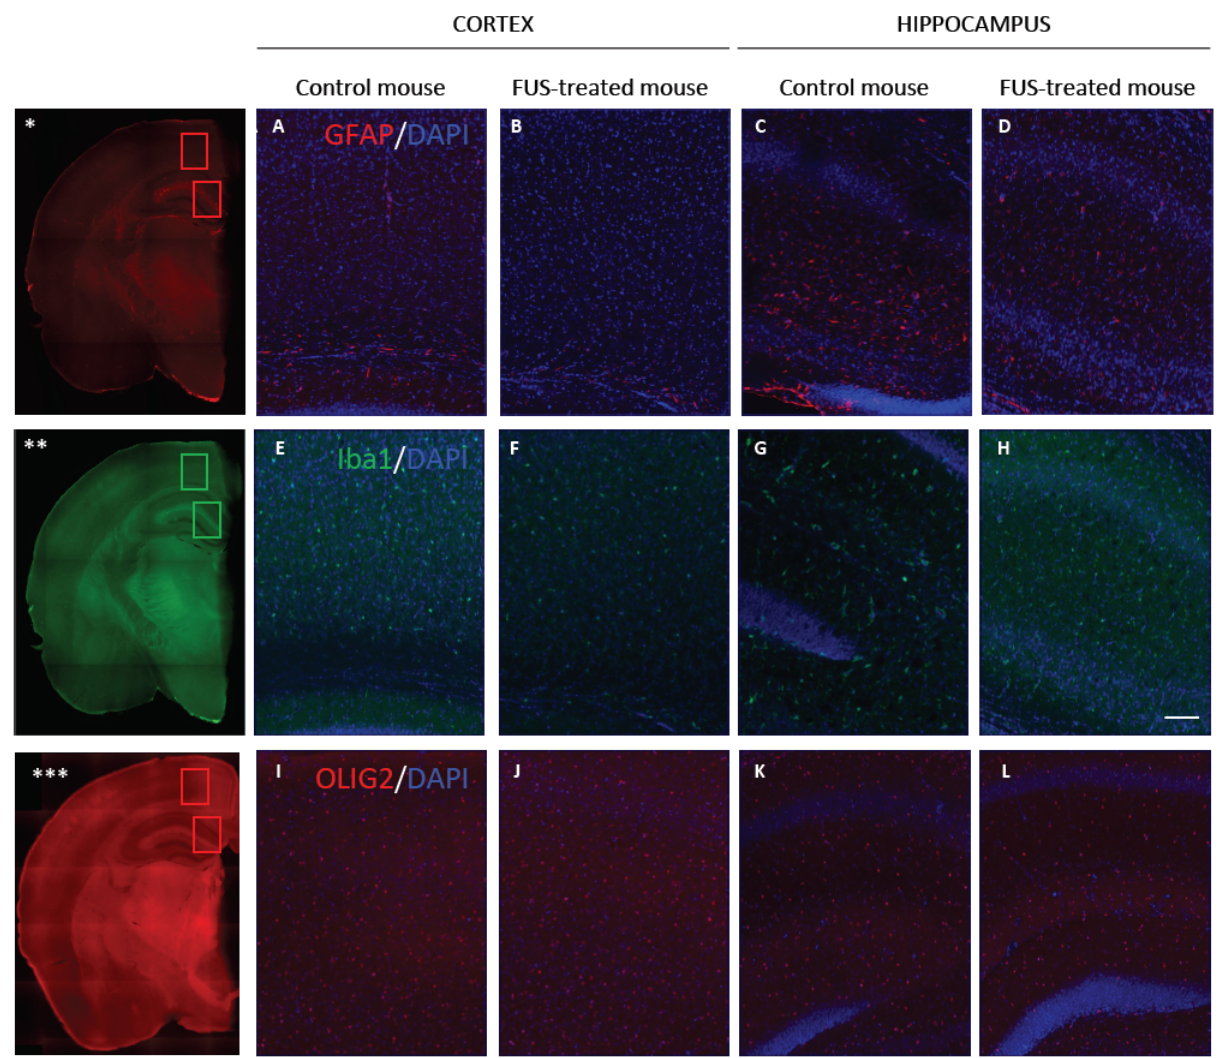
Figure 5. Long term safety study 1 month after FUS treatment did not show any inflammation, white matter damage or microglial activity. ( A – D ): GFAP immuno-fluorescent red staining in cortex ( A , B ) and in hippocampus ( C , D ) of mice that